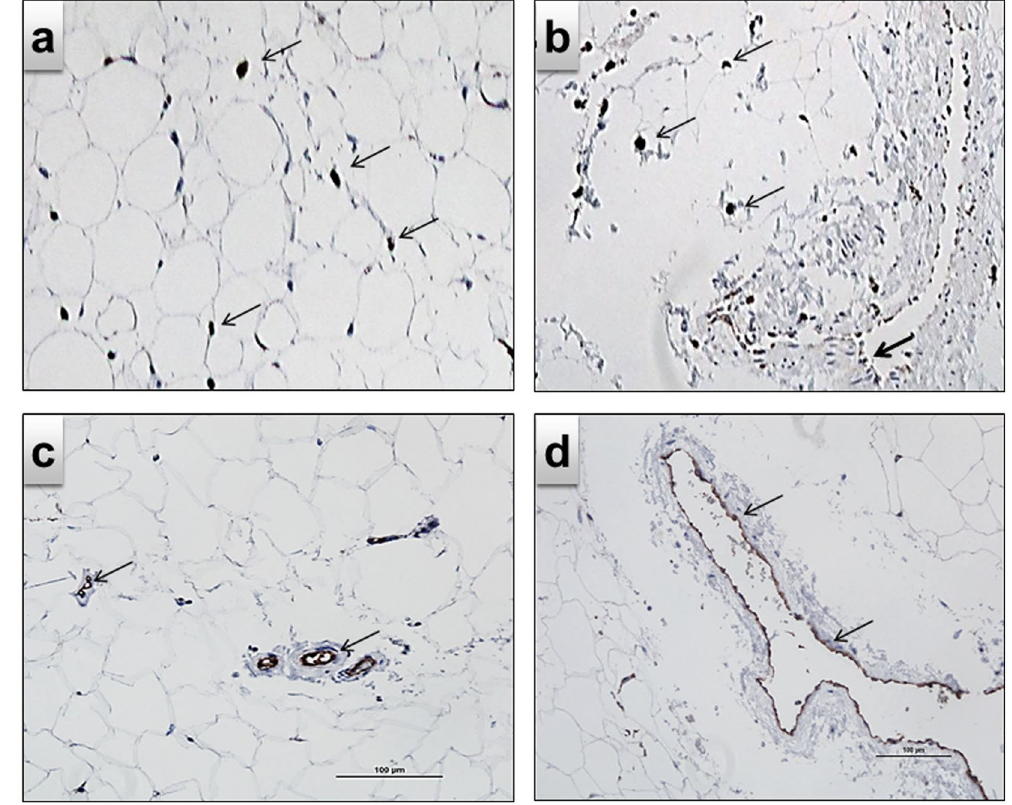
Figure 4. Immunohistochemical detection of macrophages and EC. RSF obtained from human renal resections: ( a ) CD 68, specific for both M1 and M2 macrophages, and ( b ) CD 206, a C-type lectin on macrophages, specific for M2 macrophages which are located inside the fat tissue (thin arrows) but also along blood vessels (bold arrow). Microvascularization detected by CD31 staining of EC ( c ) located between fat cells, and ( d ) larger vessels between the fat tissue. The cells are marked by brown staining (arrows). The scale bars represents 100 µ